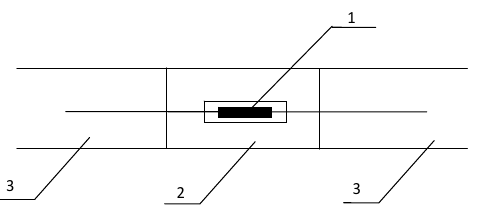
Figure 8. Schematic of FBG temperature sensors: 1—FBG sensor; 2—stainless steel case; 3—Fiber jumper.